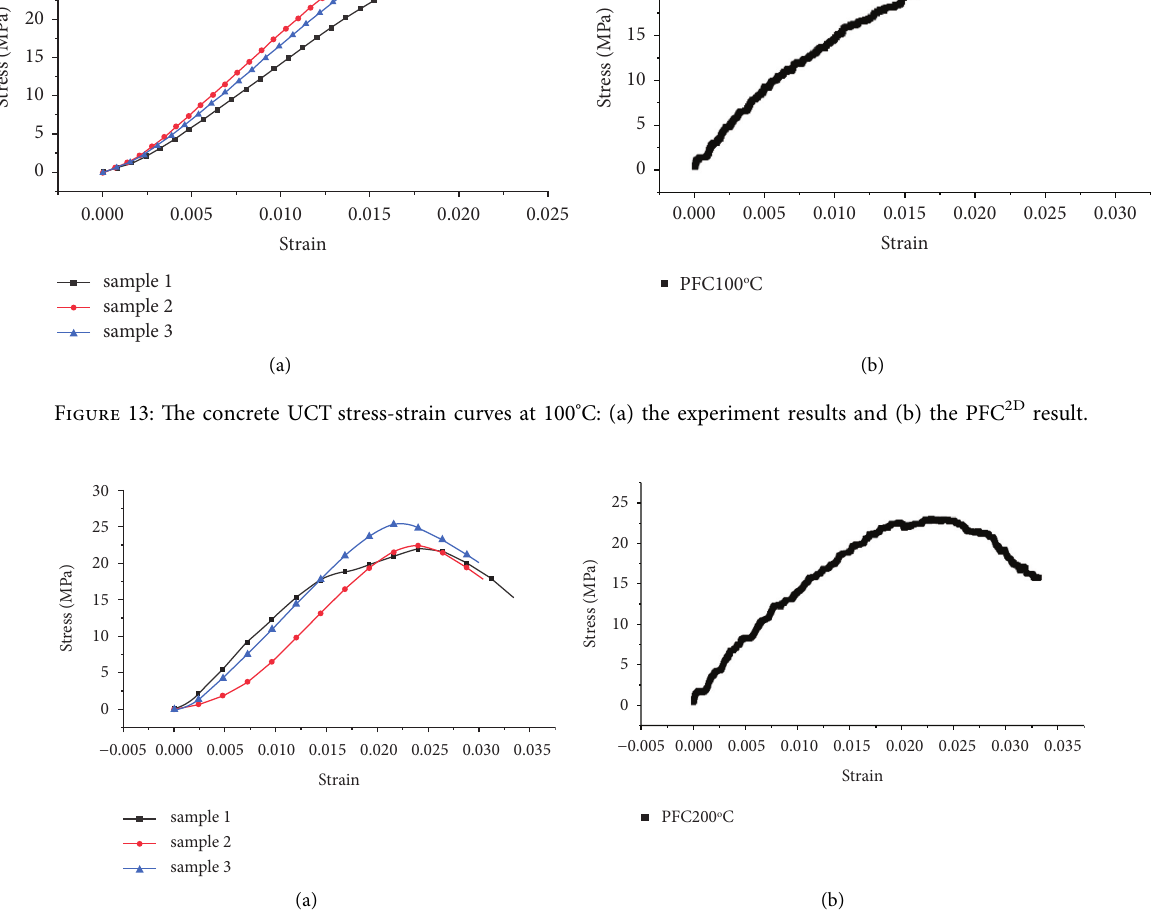
Figure 14: The concrete UCT stress-strain curves at 200 ° C: (a) the experiment results and (b) the PFC 2D